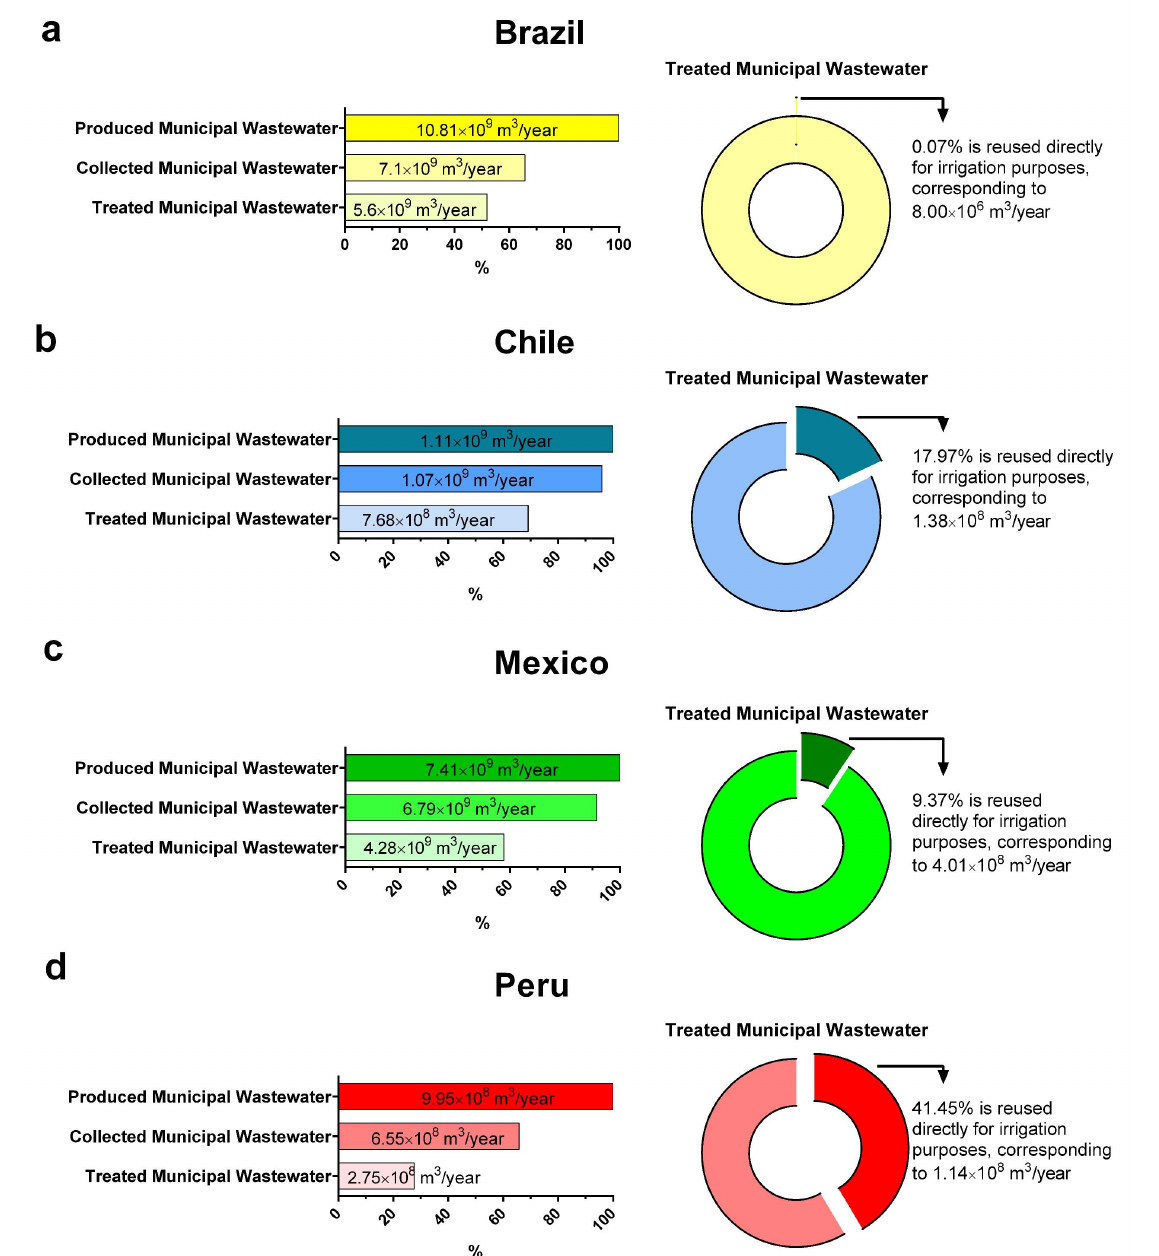
Figure 4. Amount of annual municipal wastewater produced, collected, and treated in ( a ) Brazil; ( b ) Chile; ( c ) Mexico; and ( d ) Peru. The figure also shows the amount of treated wastewater that is reused for irrigation purposes. Source: FAO (2017) [7].